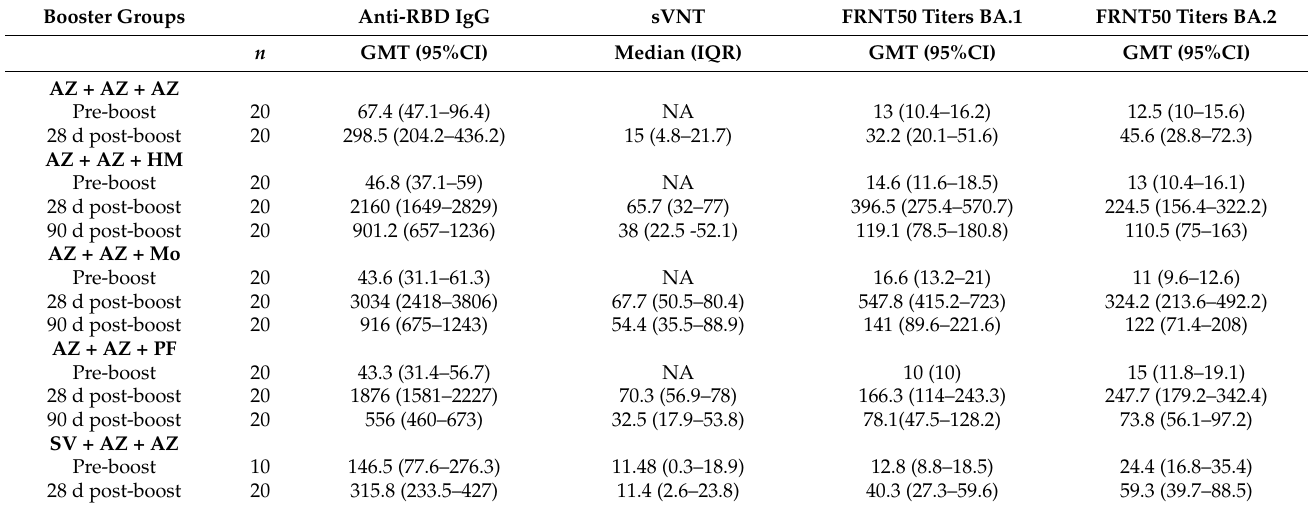
Table 1. Anti-RBD IgG against wild type, sVNT against omicron, FRNT50 titers against BA.1 and BA.2 among the booster vaccination